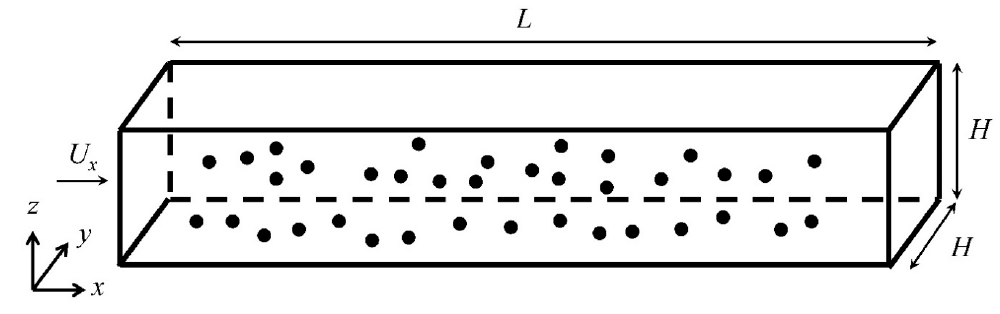
Figure 18. Schematic of agglomeration of adhesive particles in channel flow.